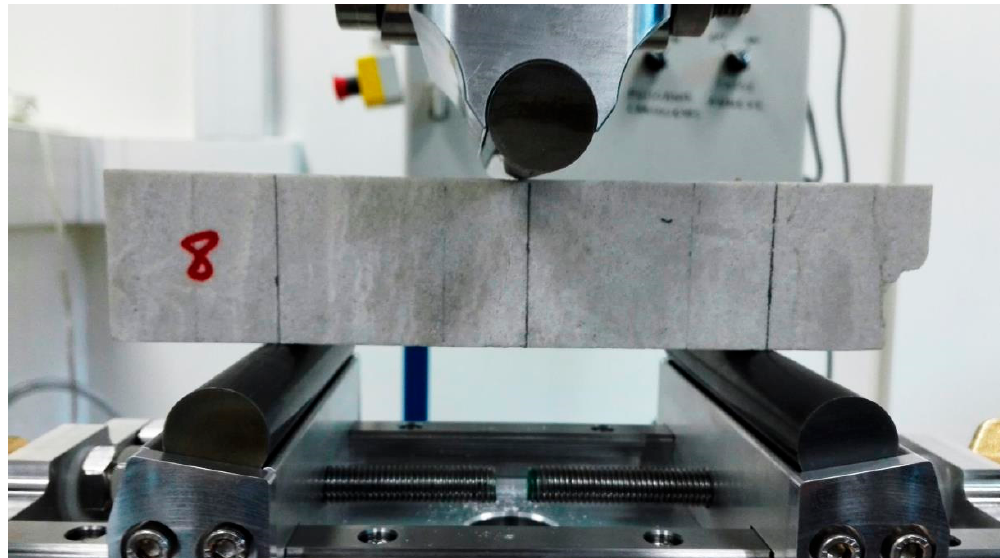
Figure 3. Set-up used for bending tests.